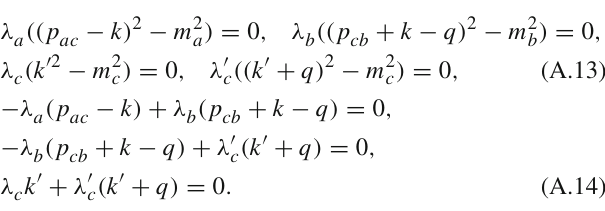
The vertical cut is taken in the right part of the